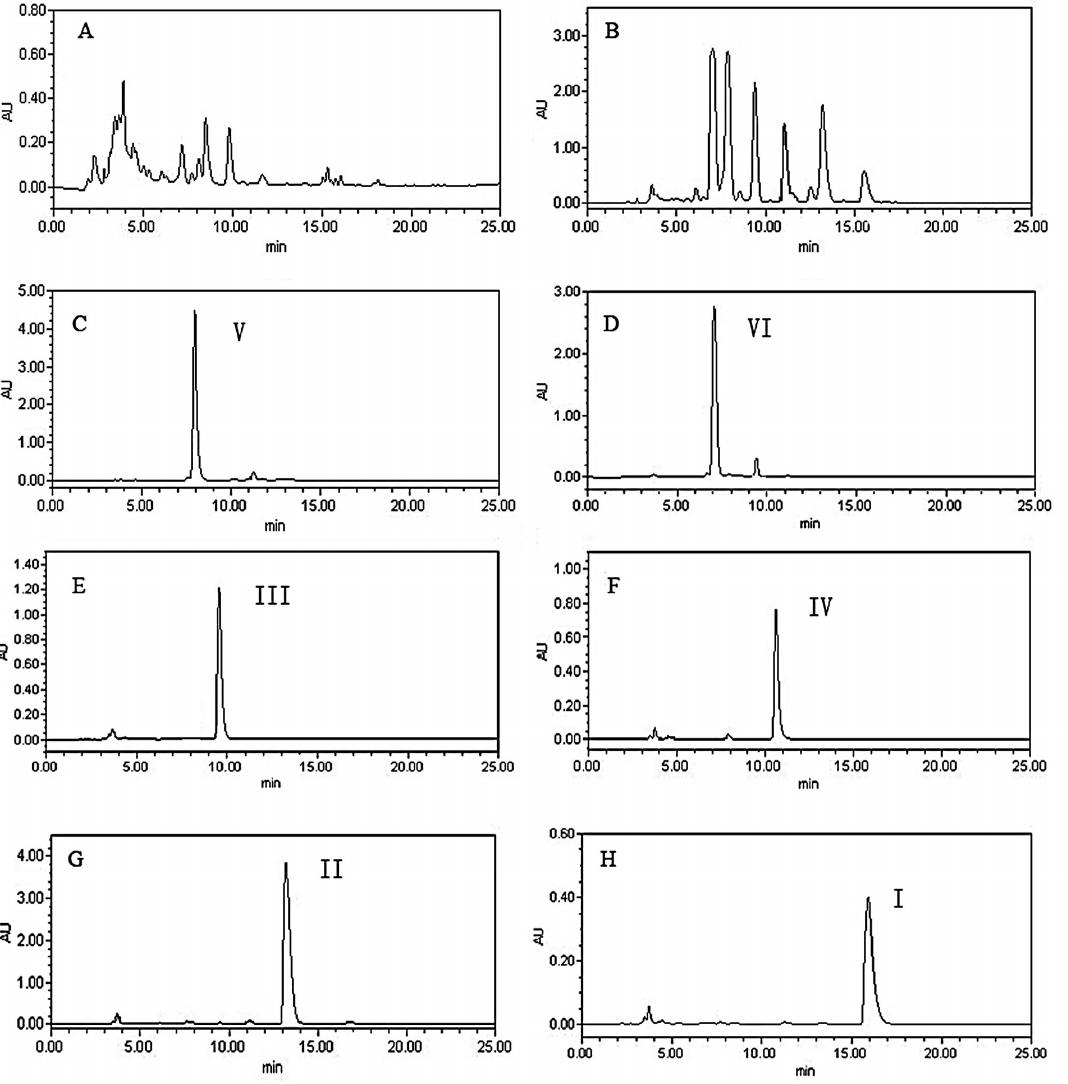
Figure 2. ( A ) HPLC chromatograms of the crude extract; ( B ) HPLC chromatograms of enriched alkaloids; ( C ) HPLC chromatograms of HSCCC peak fraction I; ( D ) HPLC chromatograms of HSCCC peak fraction II; ( E ) HPLC chromatograms of HSCCC peak fraction III; ( F ) HPLC chromatograms of HSCCC peak fraction IV; ( G ) HPLC chromatograms of HSCCC peak fraction V; ( H ) HPLC chromatograms of HSCCC peak fraction